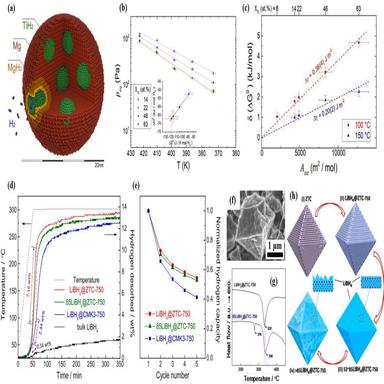
(a) Schematic of a single Mg-Ti-H biphasic nanoparticle at low Ti content with MgH2/TiH2 interface represented in yellow and nucleation and growth of MgH2 in orange, (b) Peq as a function of temperature for different XTi with dashed lines exhibiting fitting result and the inset showing corresponding calculated entropy and entropy data, (c) thermodynamical bias as a function of the interface area. (d) Desorbed hydrogen as a function of time under different temperatures for LiBH4 nanoconfined in ZTC and CMK3,